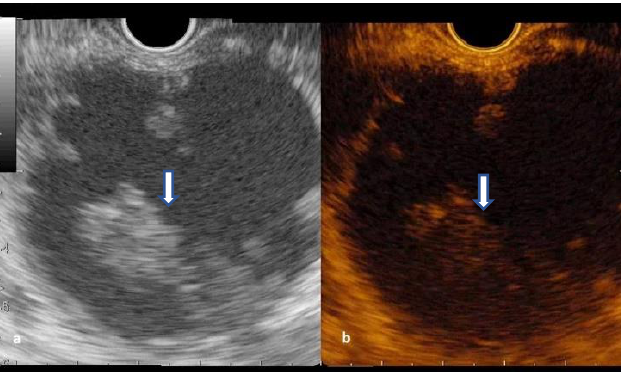
Figure 4. Walled-off pancreatic necrosis with an unenhanced solid component (arrow): ( a ) B-mode EUS; ( b ) Contrast-enhanced EUS .